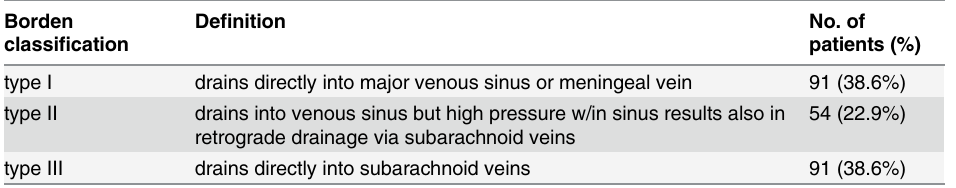
Table 1. Borden classification of DAVFs (n =